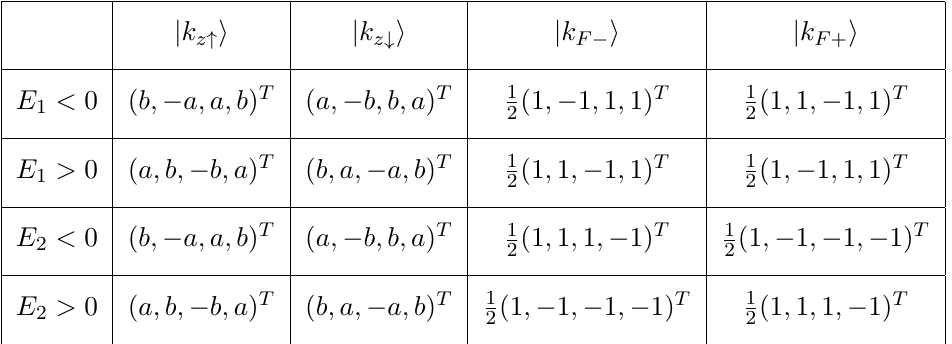
, h k , h k and h k , z ↑ | k F − i F − | k z ↓ i z ↓ | k F + i F + | k z ↑ i